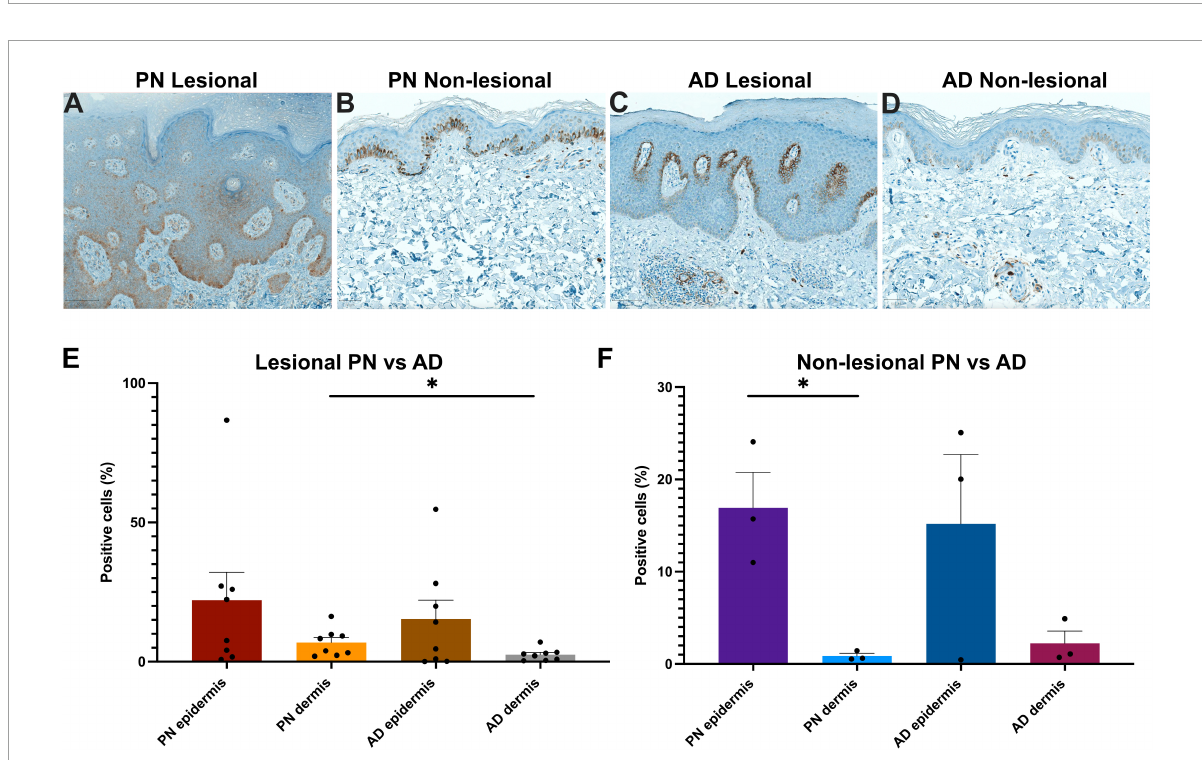
FIGURE4 Immunohistochemistry (IHC) analysis of nerve growth factor (NGF) in prurigo nodularis (PN) and atopic dermatitis (AD) skin. (A–D) Representative NGF IHC staining in PN lesional, PN non-lesional, AD lesional, and AD non-lesional skin, respectively. Panels (A,C) 10 × . Panels (B,D) 15 × . (E) Quantification of the percentage of NGF-positive cells in lesional PN vs. lesional AD skin. (F) Quantification of the percentage of NGF-positive cells in non-lesional PN vs. non-lesional AD skin. ∗ p < 0.05. The symbol “ • ” represents the percentage of positive cells for an individual